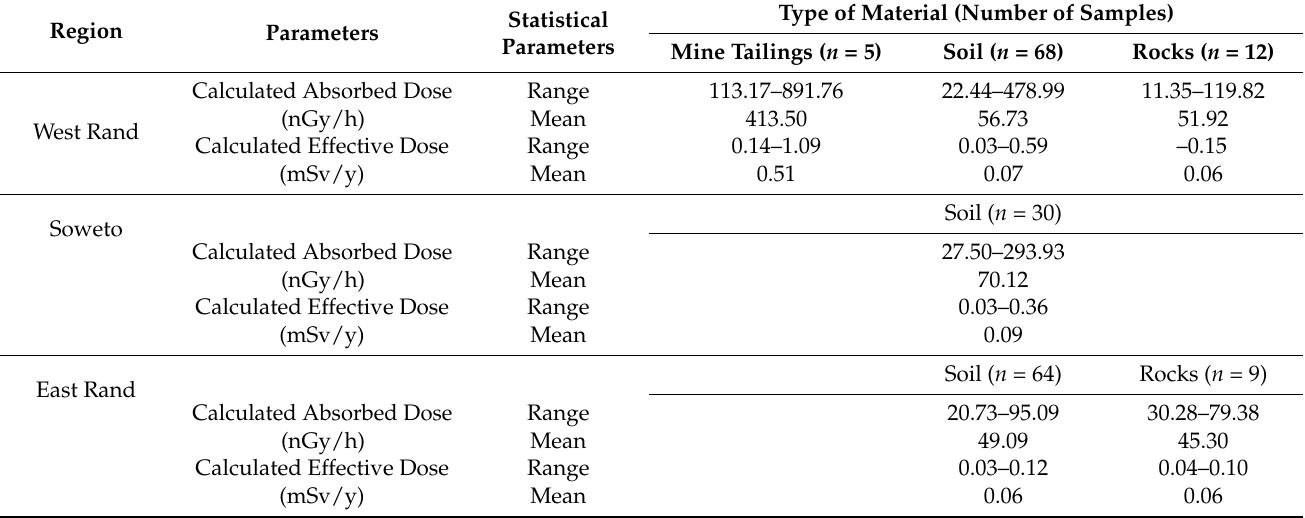
Table 4. The calculated absorbed dose rate in the air at a height of 1 m above the ground and the associated effective